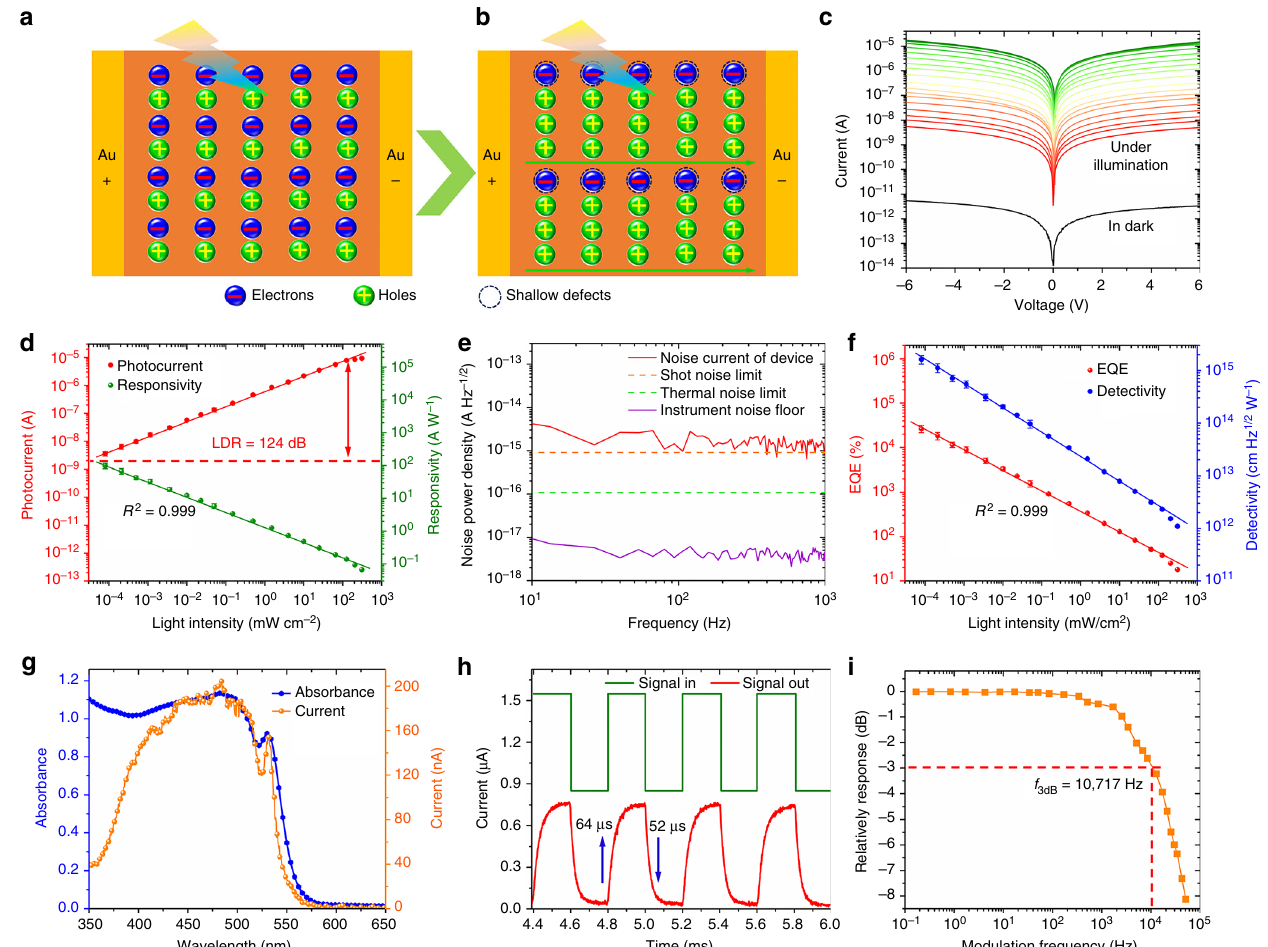
Fig. 6 Performance of fl exible (PEA) 2 PbI 4 SCM photosensor. a , b Schematic illustrations of the photoelectric process and photoconductivity gain in the present Au/(PEA) 2 PbI 4 SCM/Au device under light illumination. c The current – voltage ( I – V ) curves of the (PEA) 2 PbI 4 SCM device measured in dark and under 460 nm wavelength illumination with various light intensities. d Photocurrent and responsivity for the (PEA) 2 PbI 4 SCM photosensors within the incident light power density ranging from 8 × 10 − 5 – 310 mWcm − 2 at wavelength 460 nm under a fi xed 4 V bias. e Measured dark current noise at various frequencies of the (PEA) 2 PbI 4 SCM photosensor with a 4 V bias. The measured instrument noise fl oor, calculated shot noise, and thermal noise limit are also included for reference. f EQE and D * for the (PEA) 2 PbI 4 SCM photosensor within the incident light power density ranging from 8 × 10 − 5 – 310 mWcm − 2 at wavelength 460 nm under a fi xed 4 V bias. The points correspond to average values of measurements on 20 (PEA) 2 PbI 4 SCM photosensors, and the error bars represent the standard deviation. g Absorbance spectrum of the (PEA) 2 PbI 4 SCM and photoresponse spectrum of the photosensor illuminated using monochromatic light with wavelength ranging from 350 to 650 nm at 4 V bias. h Temporal photocurrent response of the (PEA) 2 PbI 4 SCM photosensor. i Frequency response of the (PEA) 2 PbI 4 SCM